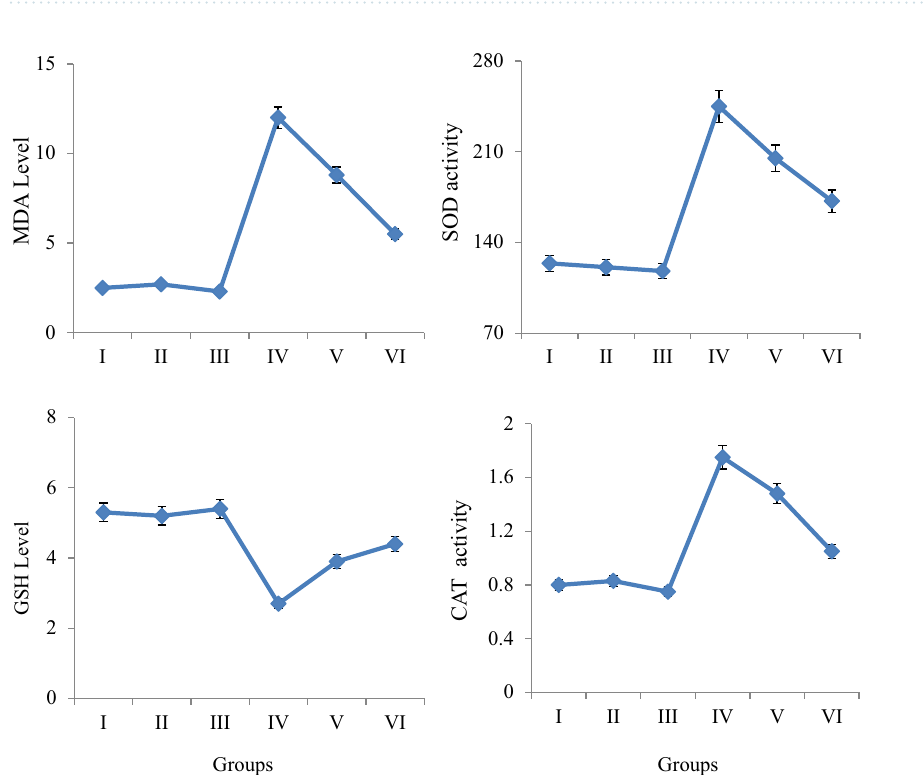
Figure 6. Protective role of GSE against biochemical toxicity induced by KBrO 3 . Group I: Control, Group II: 465 mg/L GSE, Group III: 930 mg/L GSE, Group IV: 100 mg/L KBrO 3 , Group V: 100 mg/L KBrO 3 + 465 mg/L GSE, Group VI: 100 mg/L KBrO 3 + 930 mg/L GSE. Values are shown as mean ± SD (n =